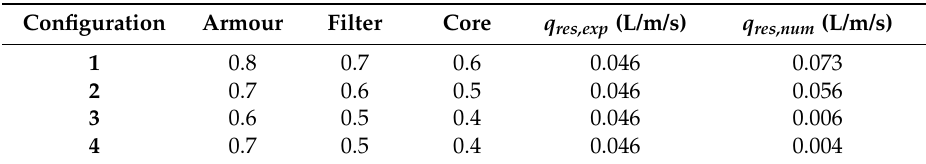
Table 2. The experimental vs. numerical q reservoir obtained by varying the porosities n assigned to the layers of the breakwater, i.e., armour, filter and